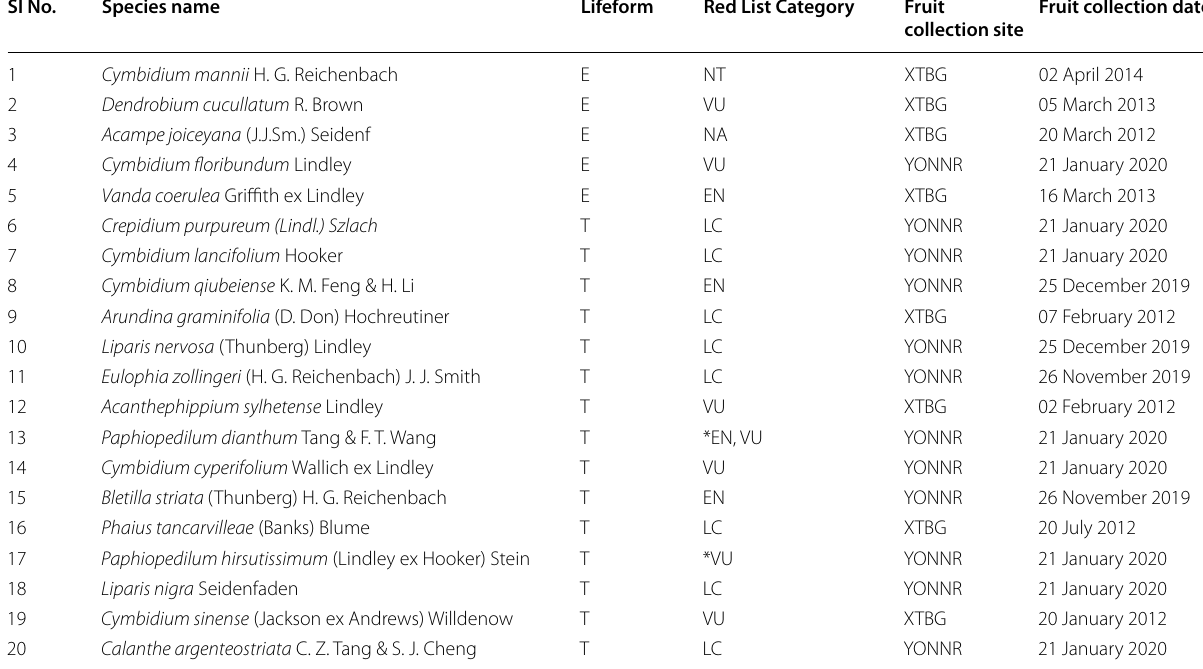
The lifeform, conservation status, fruit collection site, and fruit collection date information of the 20 orchid species used in this study. Lifeform, i.e., epiphyte (E) or terrestrial (T), was assigned based on Flora of China (eFloras, 2020). Conservation status, i.e., Endangered (EN), Vulnerable (VU), Near Threatened (NT), Least Concern (LC), Not Assessed (NA), was assigned based on Chinese red list category (Qin et al . , 2017) and IUCN red list category* (IUCN, 2020). The fruit collection sites are Yachang Orchid National Nature Reserve (YONNR) located in Guangxi and Xishuangbanna tropical botanical garden (XTBG) located in Yunnan, China